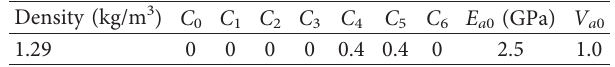
Table 3: Related parameters of the air